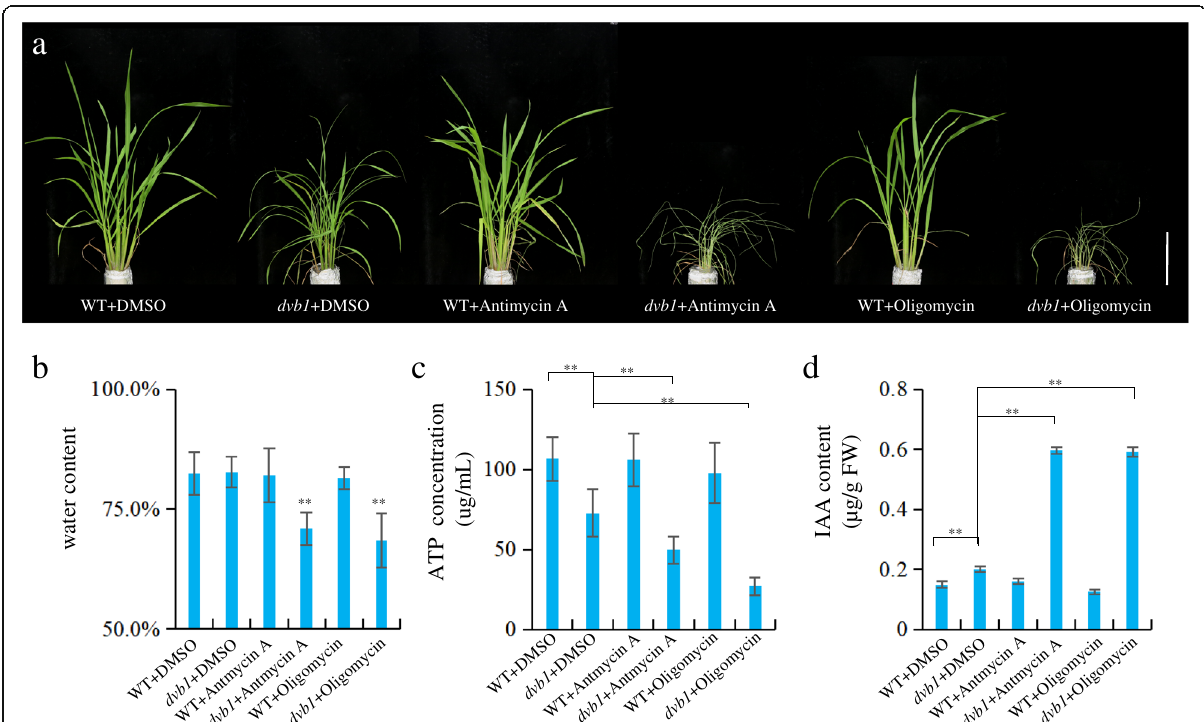
Fig. 8 Treatment with mitochondrial electron transport inhibitors. a Phenotypes of the wild type and the dvb1 mutant after treatment with 1.25 μ M antimycin A and 0.5 μ M oligomycin. The DMSO was as a control. Scale bars: 15 cm. b – d The content of water ( b ), ATP ( c ), IAA ( d ) of the wild type and the dvb1 mutant after treatment with 1.25 μ M antimycin A and 0.5 μ M oligomycin. Values represent means ± SD from 6 biological samples. Asterisks indicate the significance of differences between the wild type and dvb1 as determined by Student ’ s t-test (*, 0.01 ≤ P < 0.05; **, P <